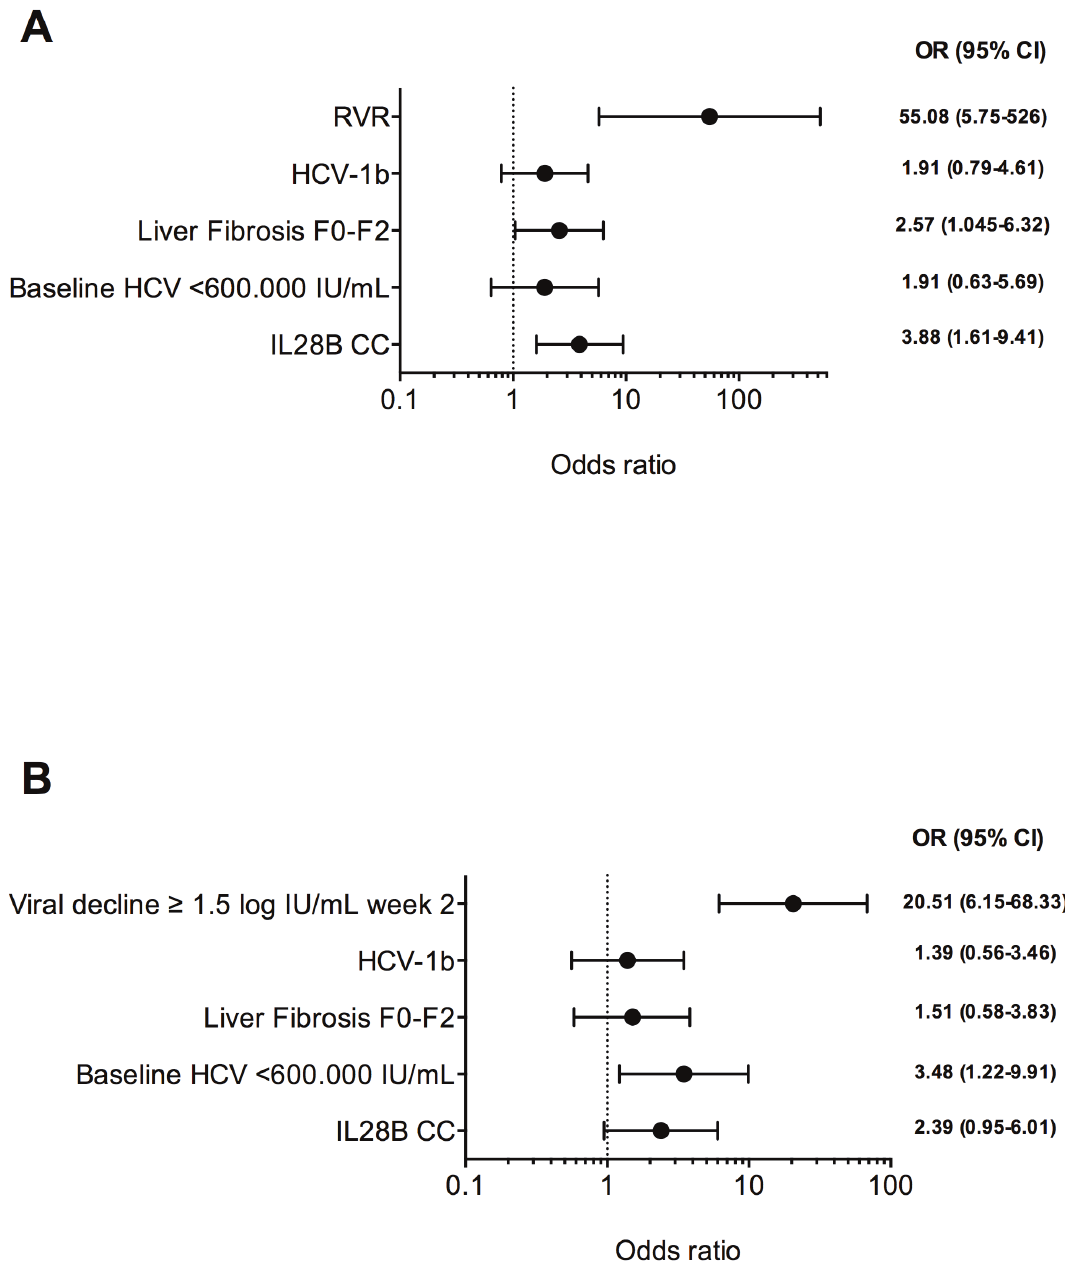
Figure 2. Multivariate logistic regression analysis for sustained virological response (SVR) including rapid virological response (RVR) (2A) and HCV viral decline of $ 1.5 log IU/mL at week 2 (2B). Odds Ratios (OR) and 95% Confidence Interval (95% CI) of each variable are shown to the right of the figure.